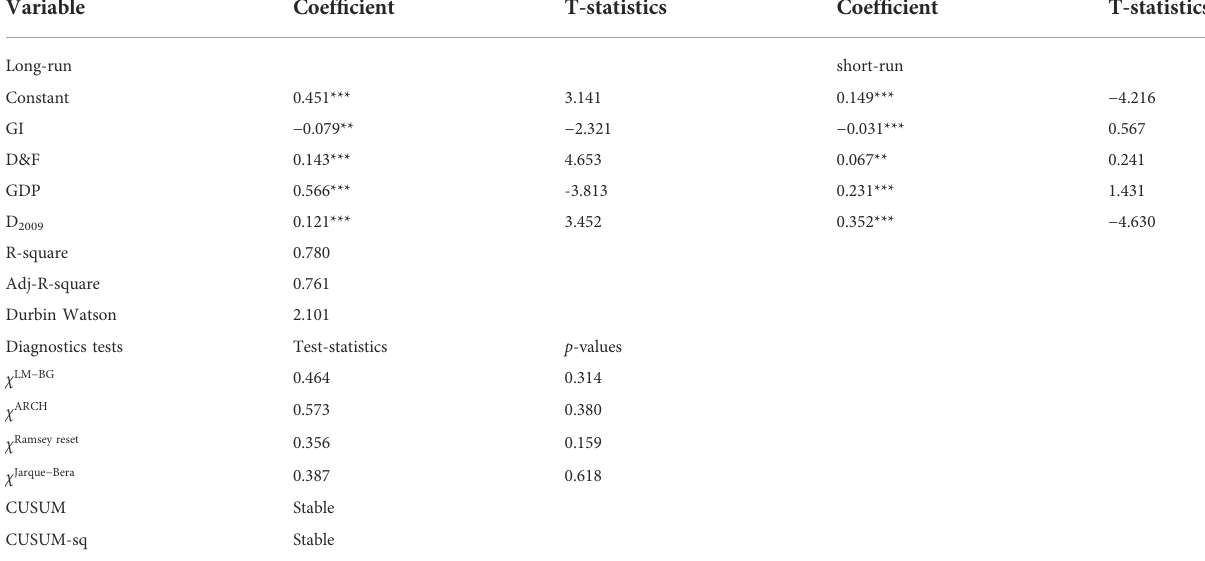
TABLE 6 BARDL long and short-run estimates and diagnostic test.